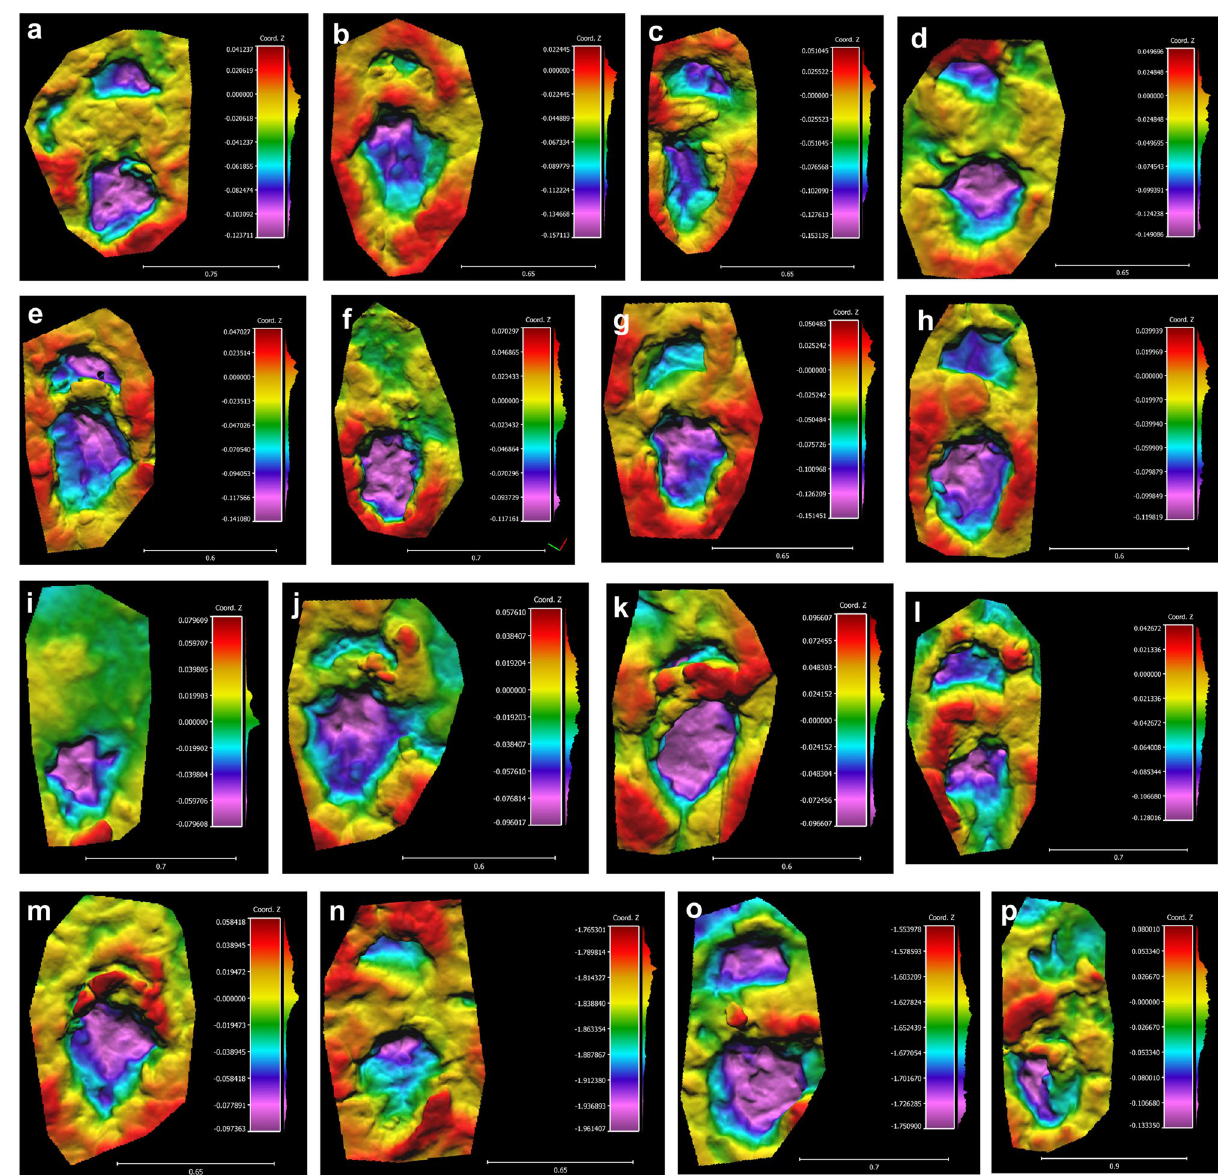
Figure 4. Las Sereas 8 tracksite. Tracks of Iniestapodus burgensis . False-color depth maps: ( a ) Pair LS8A,1p/m; ( b ) Pair LS8A,2p/m; ( c ) Pair LS8A,3p/m; ( d ) Pair LS8A,4p/m; ( e ) Pair LS8A,5p/m; ( f ) Pair LS8A,6p/m; ( g ) Pair LS8A,13p/m; ( h ) Pair LS8A,14p/m; ( i ) LS8A,16p; ( j ) Pair LS8A,19p/m; ( k ) Pair LS8A,21p/m; ( l ) Pair LS8A,22p/m; ( m ) Pair LS8A,23p/m; ( n ) Pair LS8A,24p/m; ( o ) Pair LS8A,25p/m; ( p ) Pair LS8A,26p/m. The false-color depth maps were generated with CloudCompare, a free software (http:// www. cloud compa re.